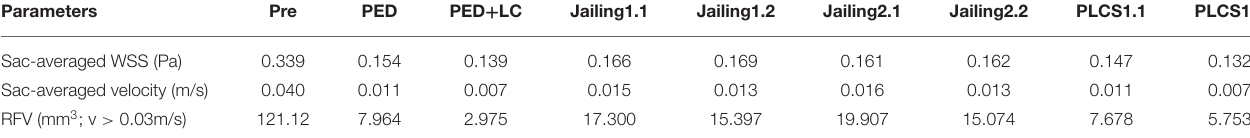
TABLE 1 | Hemodynamic parameters pre-and post-operative stimulation treatment for various stent-assisted techniques. Parameters Pre PED PED + LC Jailing1.1